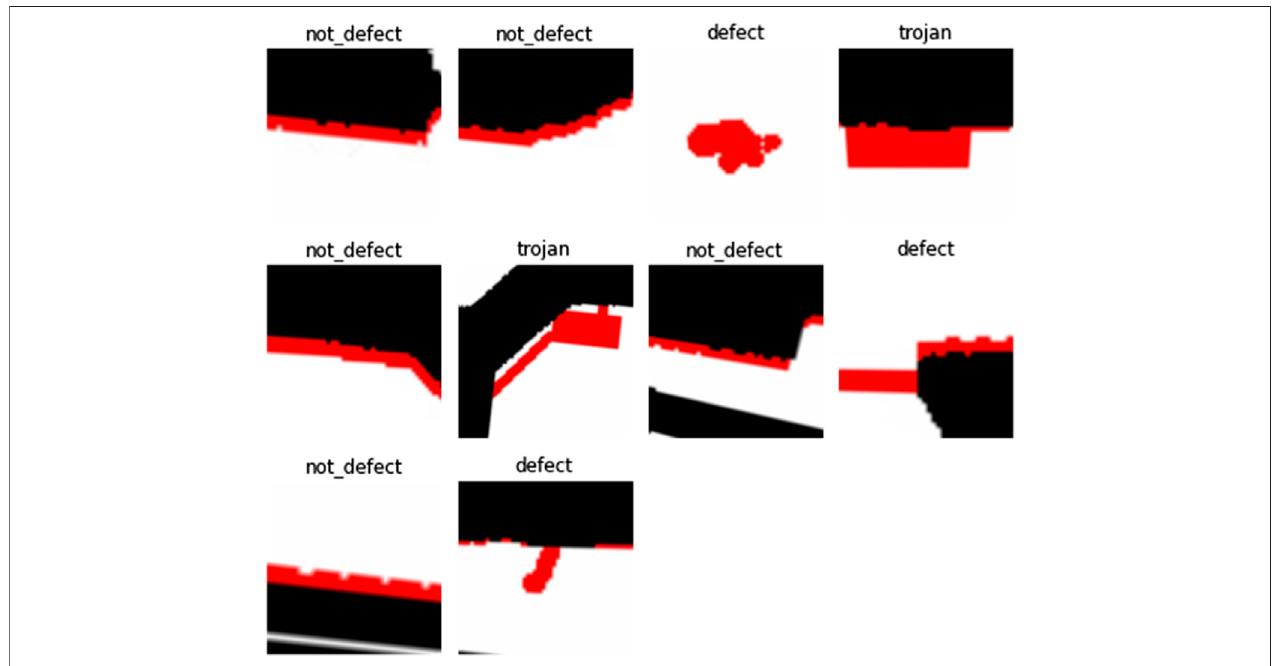
FIGURE 1 | Labelled training